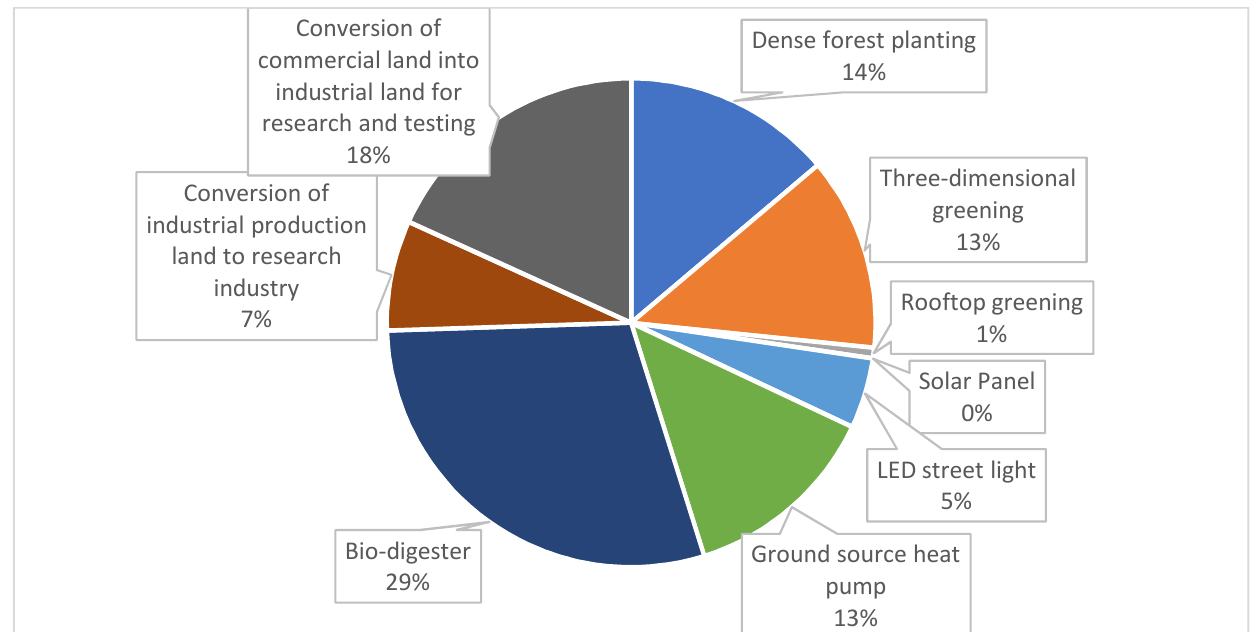
Figure 13. Change in programmatic carbon emission and sink values in the process of carbon neutrality achieved by stacking interventions.